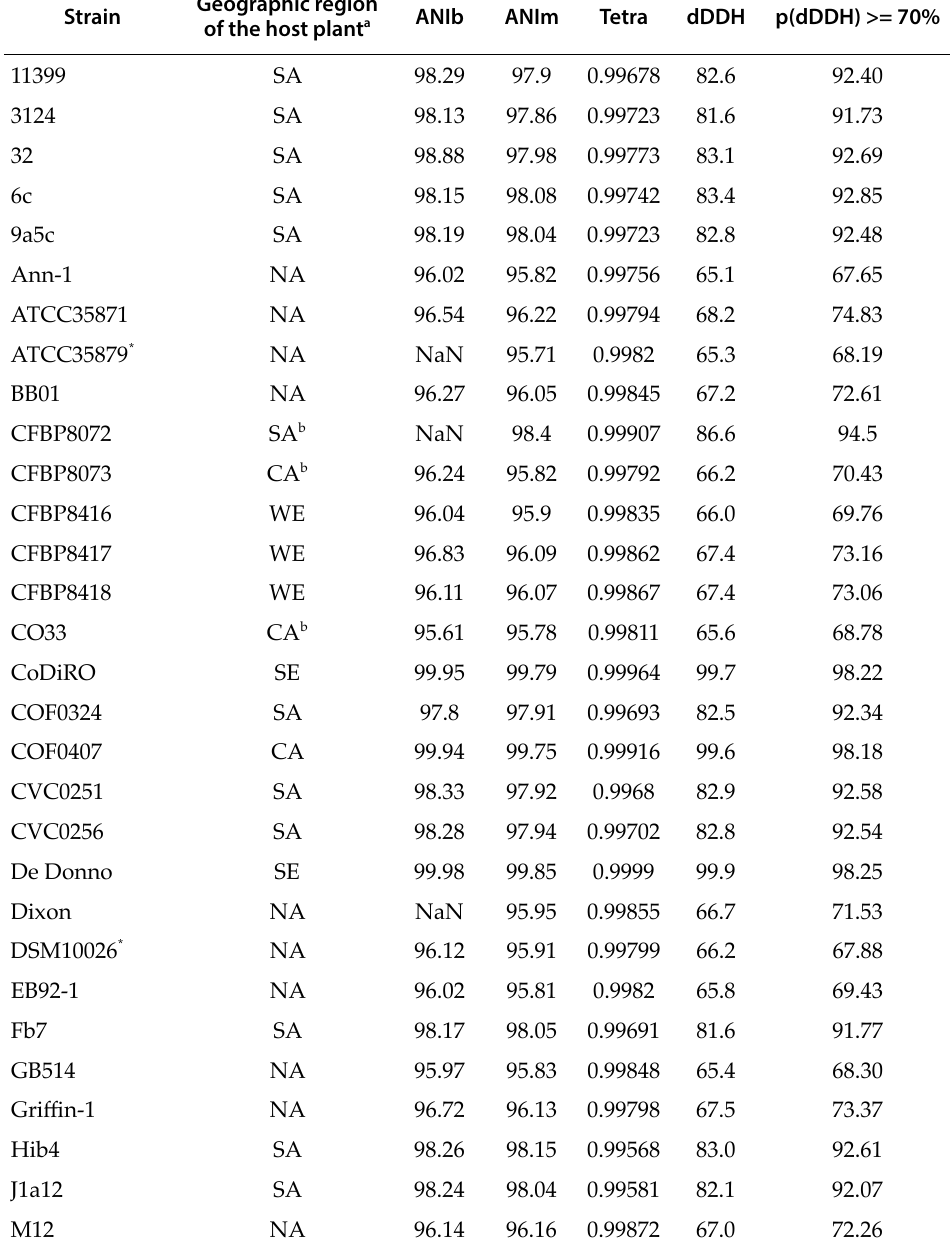
Table 3. Genome-wide indices for Xylella fastidiosa isolates.ANIb = Average Nucleotide Identity obtained using the BLAST aligner. ANIm = Average Nucleotide Identity obtained using the MUM-mer aligner. Tetra = correlation between tretramer frequency. ANIb, ANIm and Tetra were calculated with jspecies. dDDH = Digital DNA/DNA hybridization values ob - tained with GGDC 2.1 (DDH-2 value only is reported because of its greater accuracy with incomplete genomes). Calcula- tions were carried out with respect to the X. fastidiosa Salento-1 isolate. SE = Southern Europe (039), WE = Western Europe (155), CA = Central America (013), SA = South America (005), NA = North America